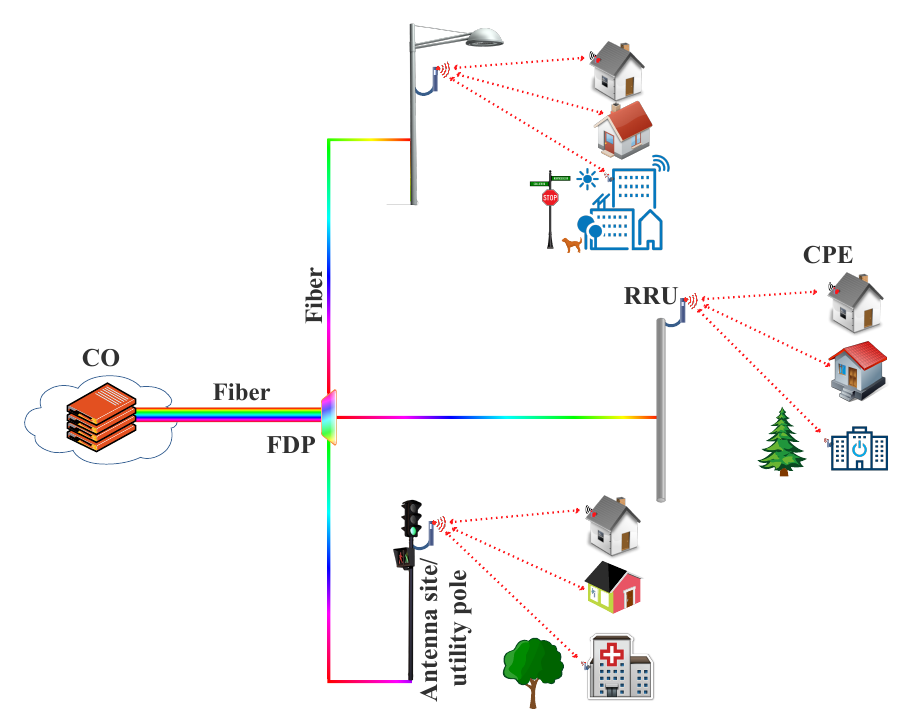
Figure 11. FWA deployment scenario (adapted from